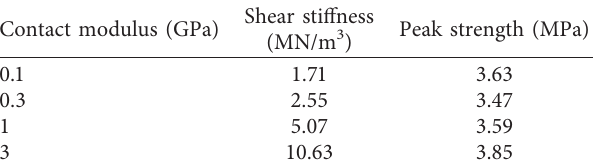
Table 4: Relationship between contact modulus and shear stiffness and peak strength of specimens.